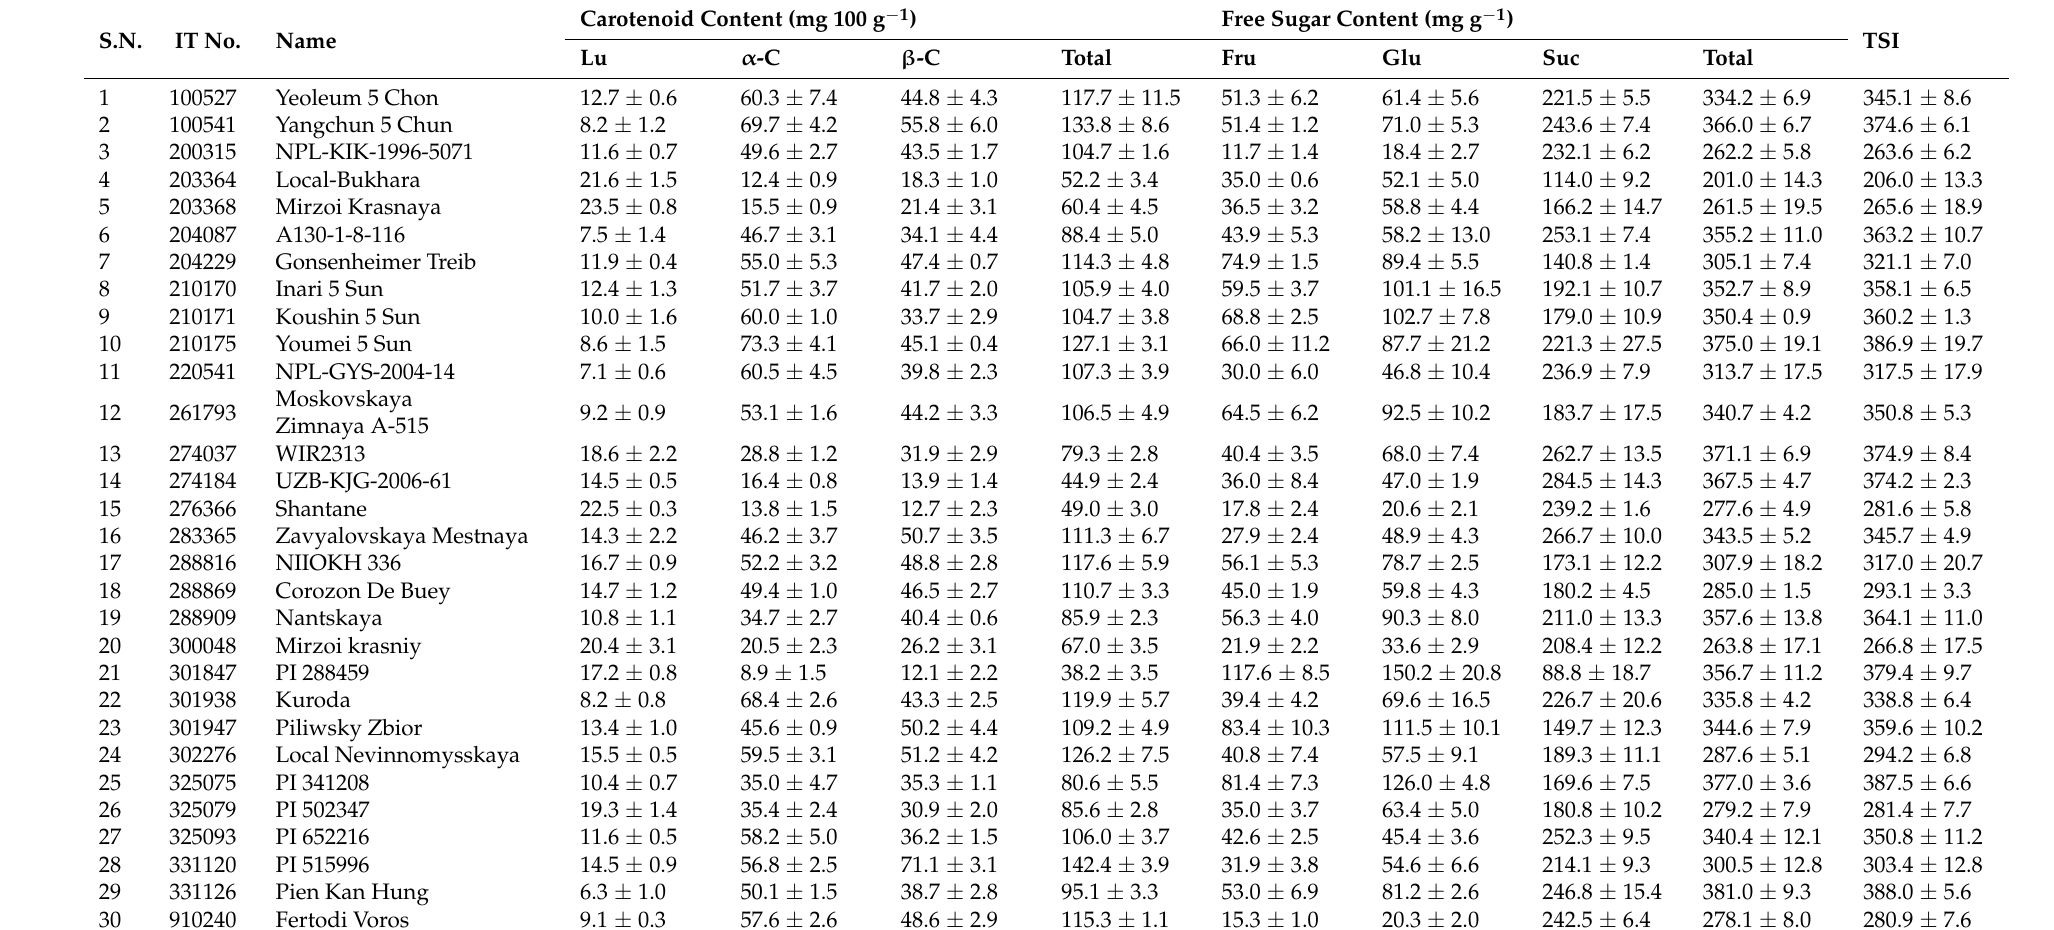
Table 6. Selected carrot genetic resources with higher carotenoids, free sugar, and total sweetness index (TSI).